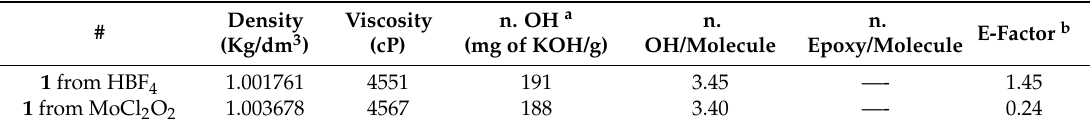
Table 1. Physical and chemical characteristics of bio-polyol 1 .